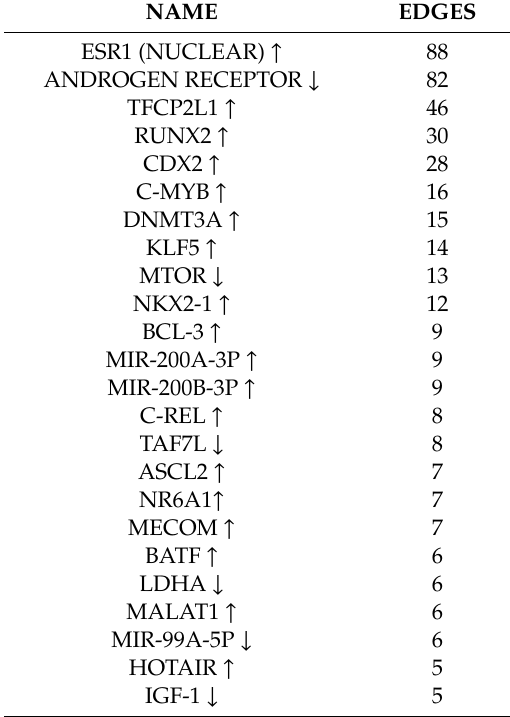
Table 3. List of proteins with five or more direct connections (defined as hubs) between up- or down-regulated features in NE-like vs. AdenoPCa samples. Arrows indicate up-regulated ( ↑ ) and down-regulated ( ↓ ) genes,